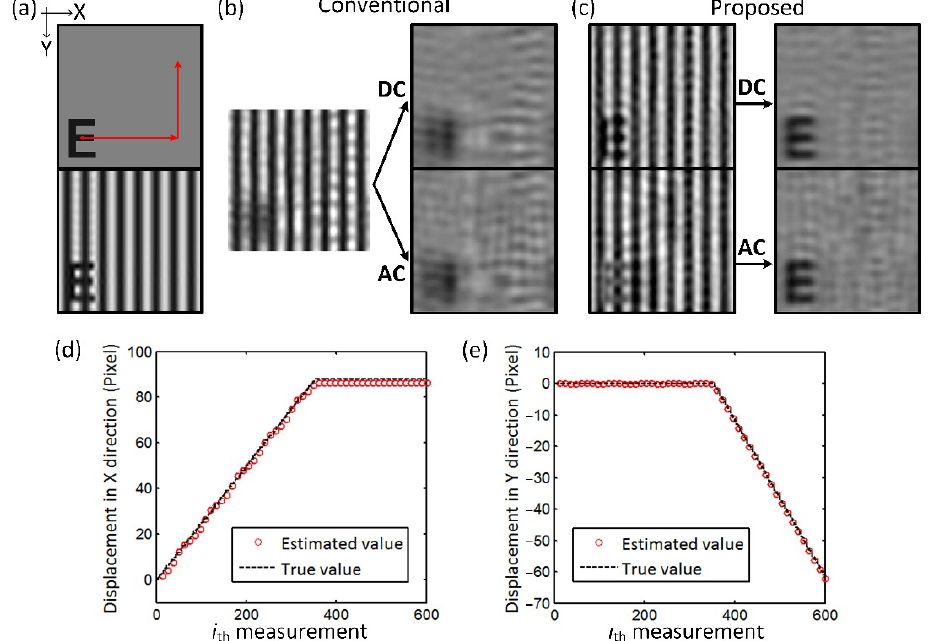
Figure 3. Simulation results of the target in piecewise uniform motion. ( a ) True target images. Red arrows show the moving path and directions of the target. Results obtained using ( b ) conventional single-pixel SFDI and ( c ) the proposed method. Target displacements in ( d ) X and ( e ) Y directions, calculated from motion estimation.